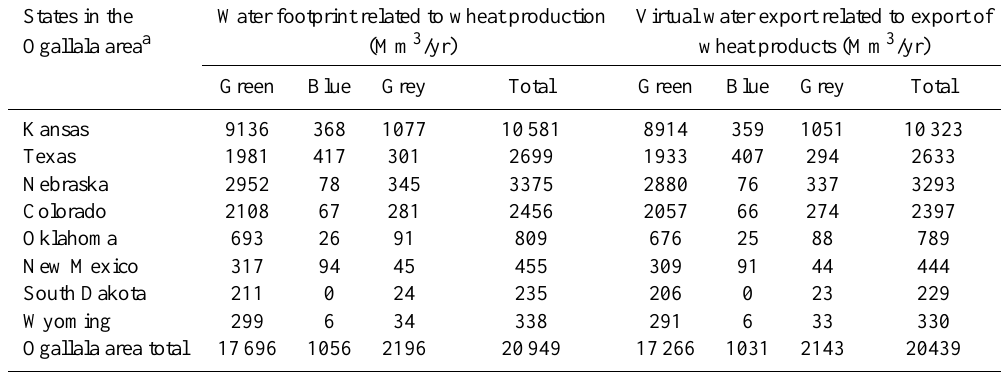
Table 6. Water footprint of wheat production and virtual water export from the Ogallala area (1996–2005). States in the Water footprint related to wheat production Virtual water export related to export of Ogallala area a (Mm 3 /yr) wheat products (Mm 3 /yr) Green Blue Grey Total Green Blue Grey Total Kansas 9136 368 1077 10581 8914 1051 10323 Texas 1981 417 301 2699 294 2633 Nebraska 2952 78 345 3375 Colorado 2108